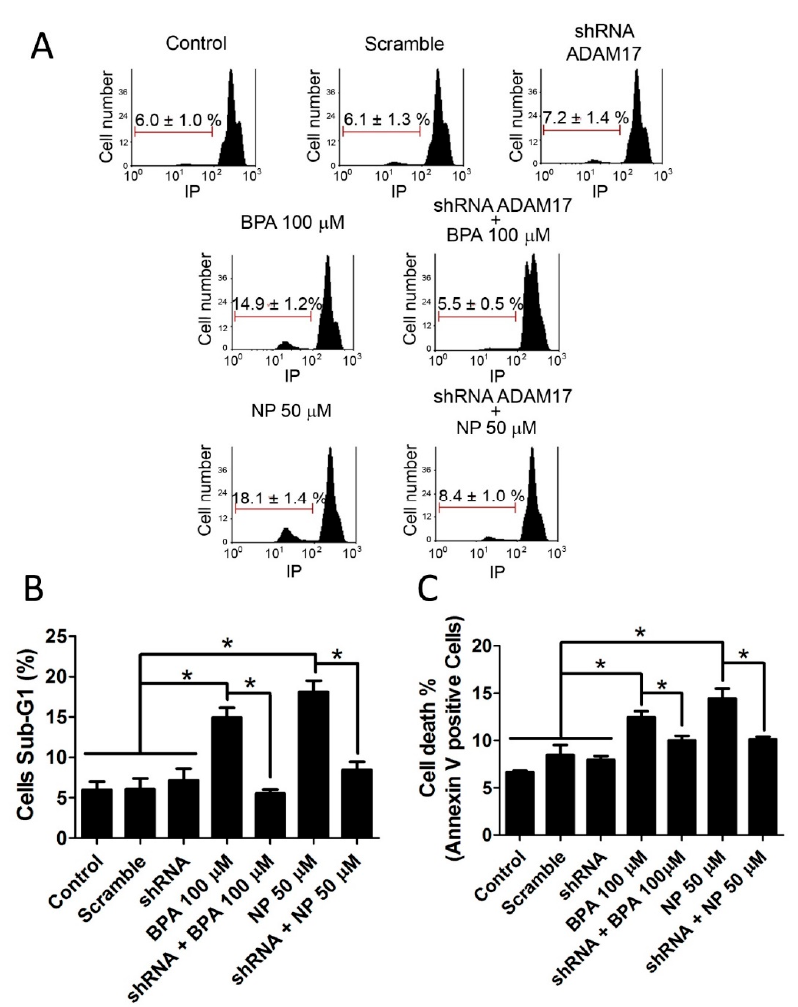
Figure 3. Silencing of ADAM17 prevents an increase in the sub-G1 population and Annexin-V-positive cells induced by BPA or NP in LNCaP cells. ( A ) Sub-G1 population analysis in LNCaP cells after 6 h of exposure to 100 μ M BPA or 50 μ M NP. Marker in each panel indicates 6 h of exposure to 100 µ M BPA or 50 µ M NP. Marker in each panel indicates sub-G1 cell population. sub-G1 cell population. ADAM17 knocked down with 10 μ g shRNA prevents the increase in the ADAM17 knocked down with 10 µ g shRNA prevents the increase in the percentage of sub-G1 cell percentage of sub-G1 cell population ( B ) or Annexin-V-positive cells ( C ) induced by BPA or NP. population ( B ) or Annexin-V-positive cells ( C ) induced by BPA or NP. Mean ± SEM, * p < 0.05, n = Mean ± SEM, * p < 0.05, n = 3.